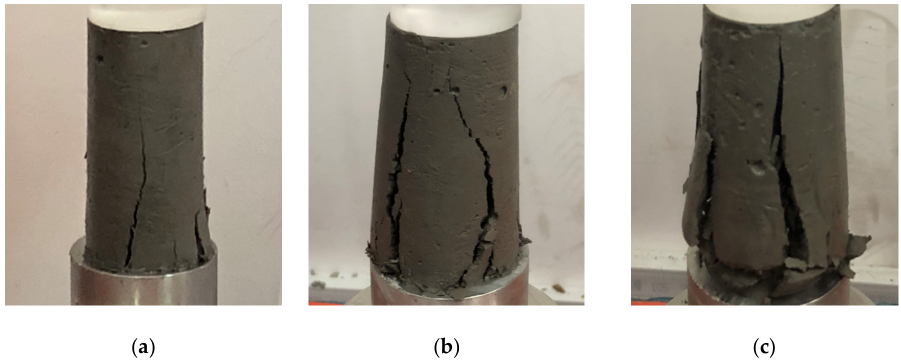
Figure 7. Failure pattern of OCC after UCS test under various freeze–thaw cycles. ( a ) 0 cycle; ( b ) 5 cycles; ( c ) 15 cycles.